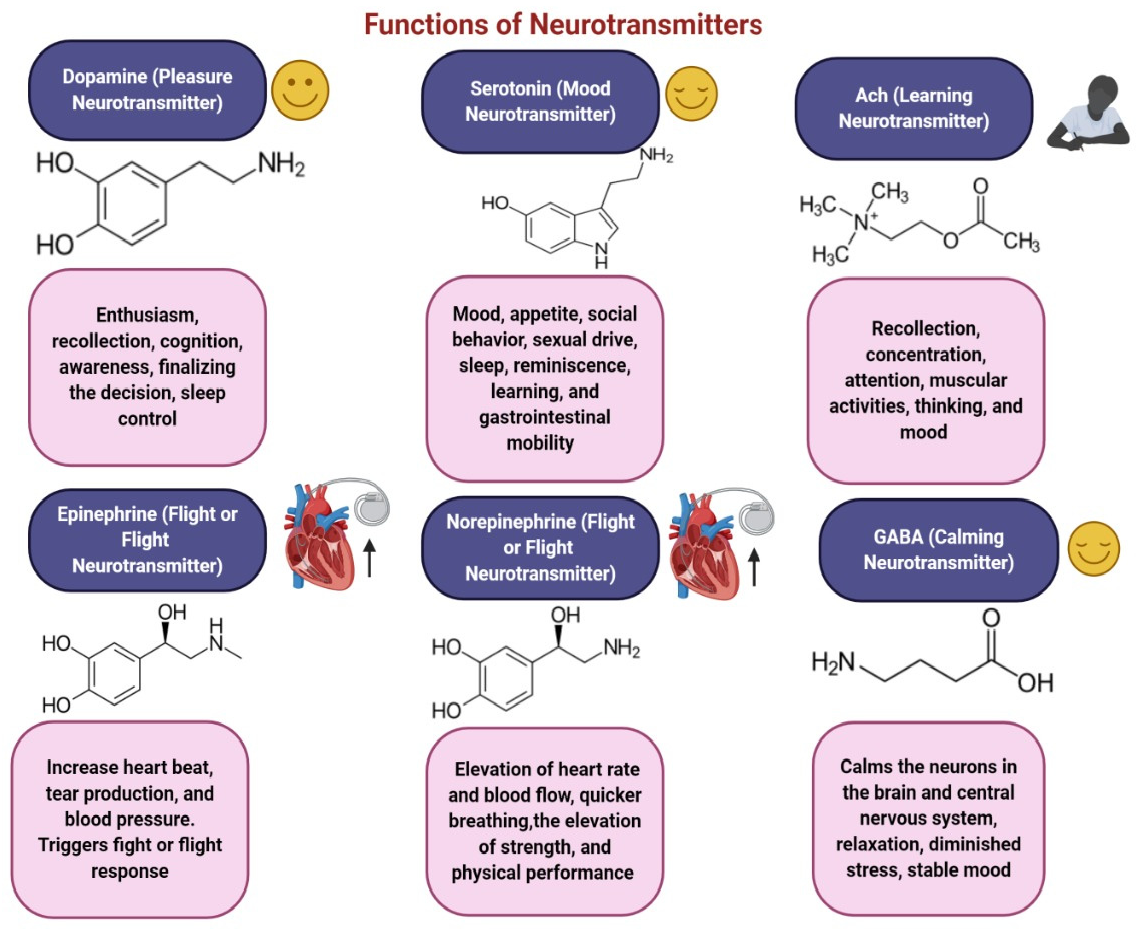
Figure 2. Illustration of major NTs along with their functions and chemical structures.